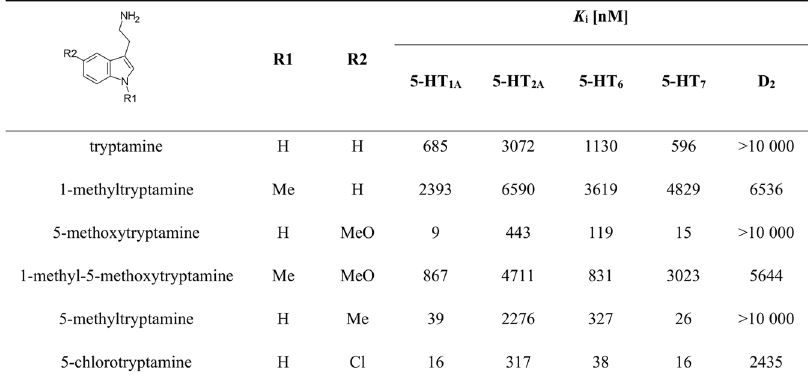
Figure 7. Structure and pharmacological profile of tryptamine